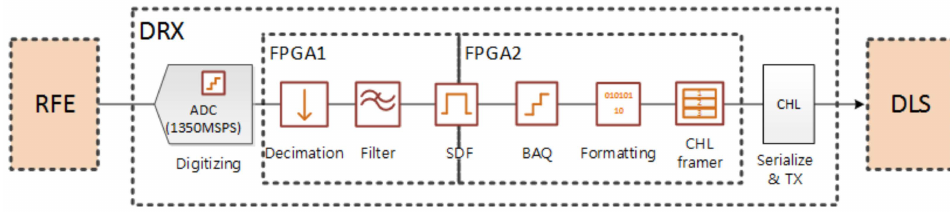
Figure 1. Functional diagram of data processing for